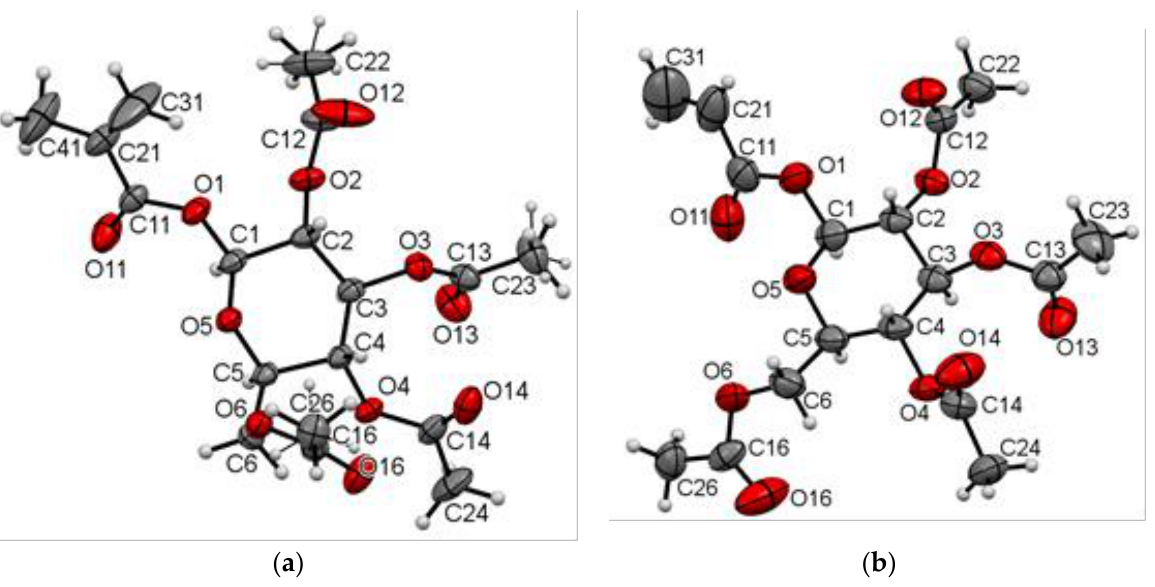
Figure 7. Perspective view of molecules: ( a ) MGlc and ( b ) AGlc- M . The thermal ellipsoids are shown at a 30% probability level).